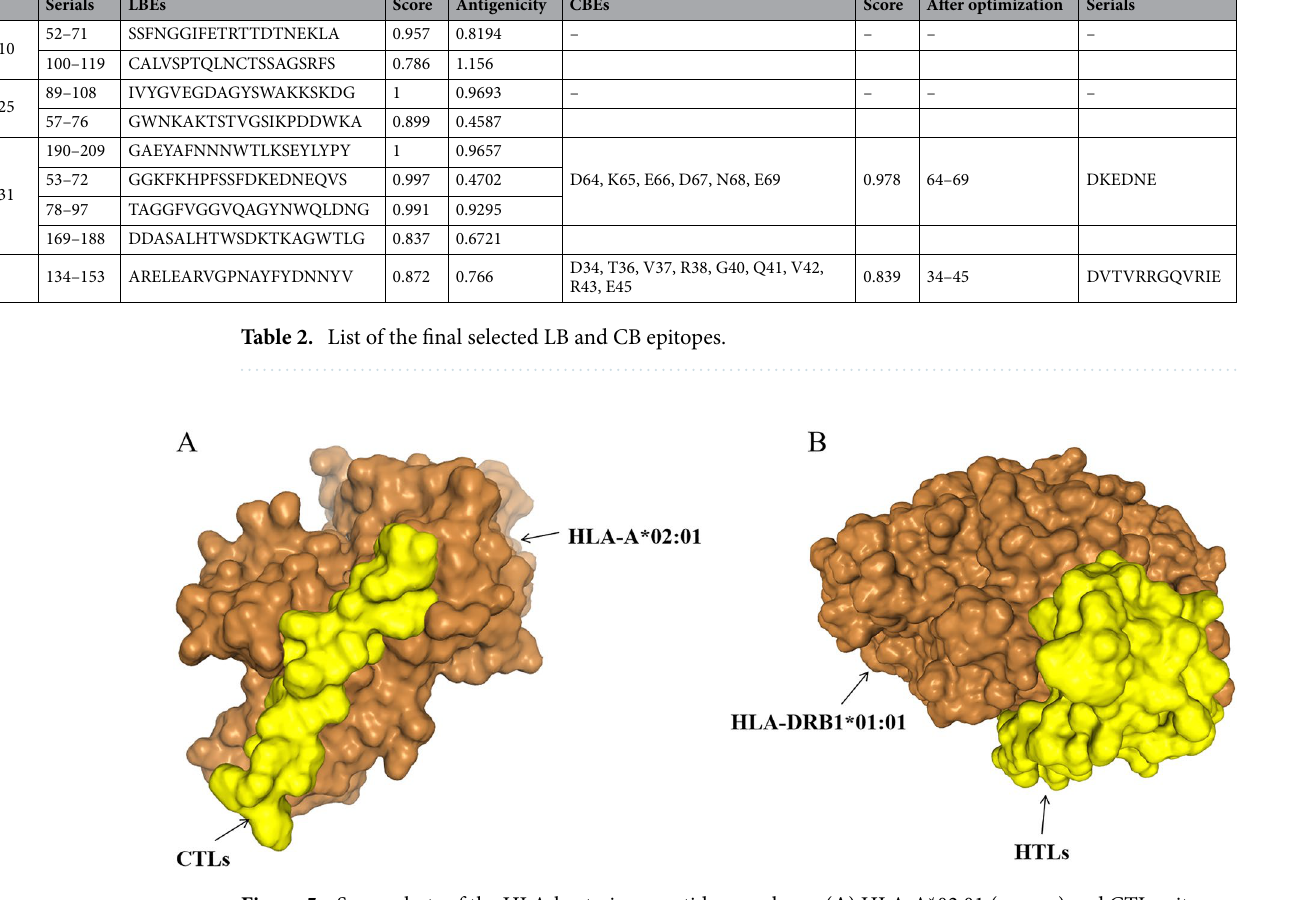
Figure 5. Screenshots of the HLA-bacterium peptide complexes. ( A ) HLA-A*02:01 (orange) and CTL epitopes (yellow) docking result. ( B ) HLA-DRB1*01:01 (orange) and HTL epitopes (yellow) docking